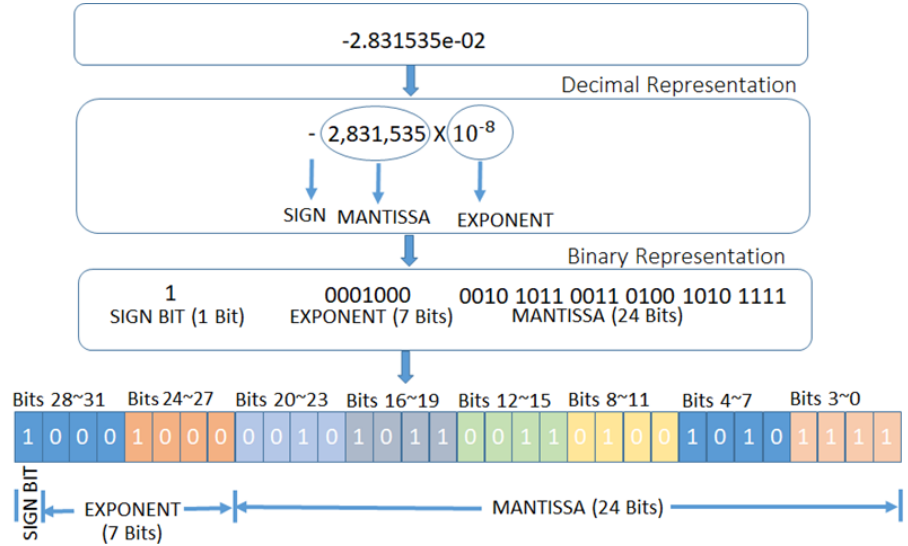
Figure 7. RRAM weights representation in binary (Floating points values).